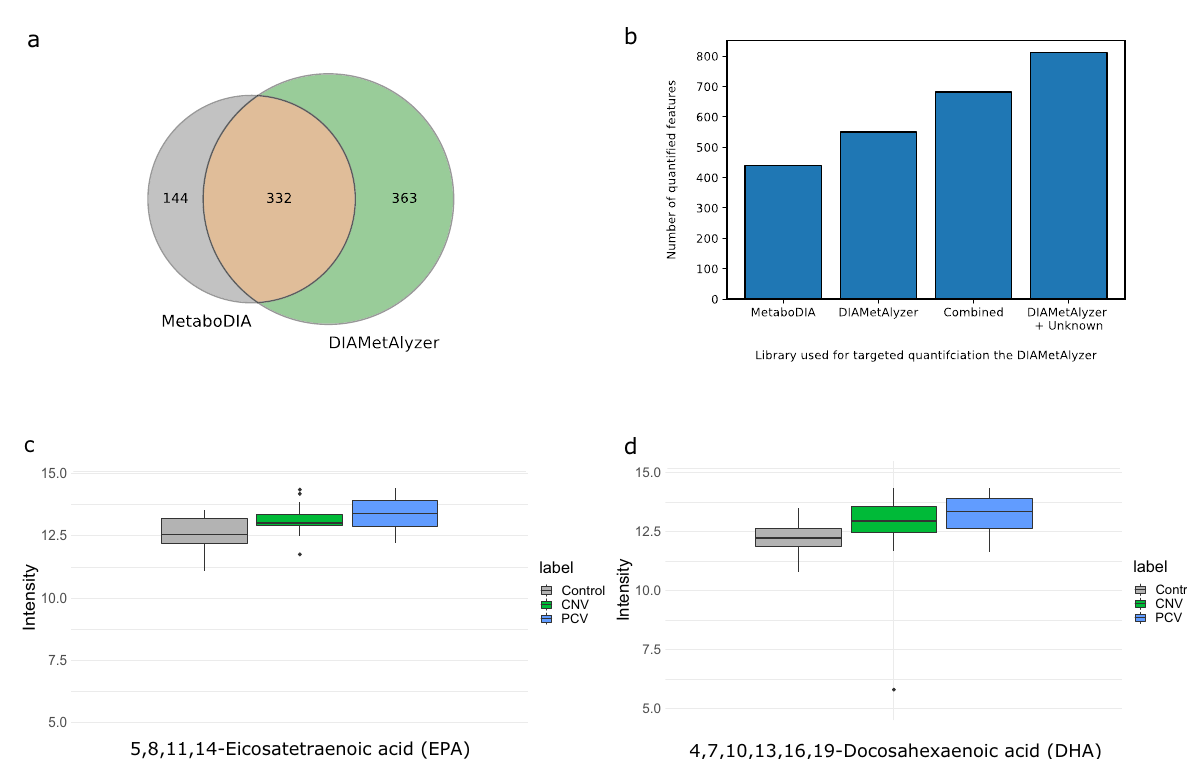
Fig. 4 Analysis of serum samples of patients with AMD using MetaboDIA and DIAMetAlyzer. a Comparison of the library generation of both tools based on features (molecular formula, adduct and retention time). 66% of the features overlap between the tools (DIAMetAlyzer: green, MetaboDIA: gray, Overlap: orange). b Number of quanti fi ed features using the various libraries in combination with the targeted extraction of DIAMetAlyzer. MetaboDIA, DIAMetAlyzer, the library of both tools (Combined), DIAMetAlyzer with the functionality to use known unknowns without prior MS1 identi fi cation additionally to the ones with identi fi cation (DIAMetAlyzer + Unknowns). c Signi fi cant deregulated compound 5,8,11,14-Eicosatetraenoic acid (EPA - C20H32O2 - based on putative identi fi cation) ( P CNV = 0.04; P PCV = 0.01) with an increase in mean intensity of 1.4 and 1.7 times in contrast to the control. d Signi fi cant deregulated compound 4,7,10,13,16,19-Docosahexaenoic acid (DHA - C22H32O2 - based on putative identi fi cation) ( P CNV = 0.008; P = 0.006) with an increase mean intensity of 1.7 and 2.0 times in contrast to the control. c , d The identi fi cation of the compounds is based on MS1 PCV accurate mass search and MS2 fragment annotation. Differential expression was assessed using limma with Benjamini-Hochberg correction. Box plots indicate median, 25th and 75th percentiles (middle line, Q1 and Q3 within the box, respectively), including 1.5x interquartile range whiskers and outliers (single points outside this range). Control: gray, n = 20 biologically independent samples, CNV (choroidal neovascularization): green, n = 20 biologically independent samples, PCV (polypoidal choroidal neovascularization): blue, n = 20 biologically independent